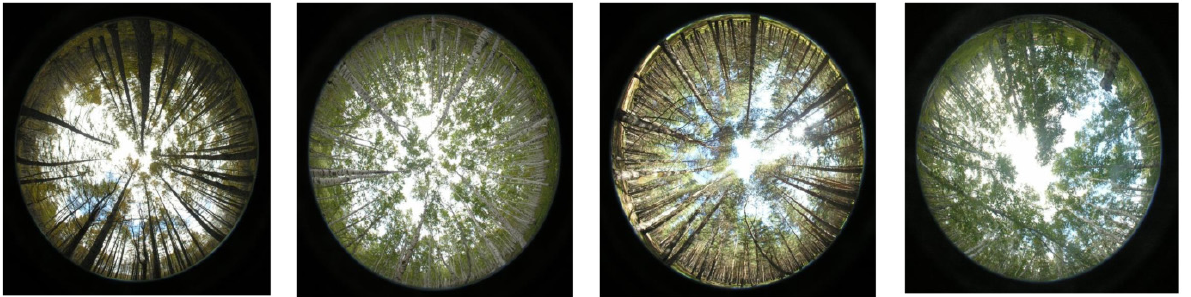
Figure 4. Partial display of fisheye photos in sample plots. The size of field plots was set 30 × 30 m, and three fisheye photos were acquired at each field plot randomly. FCC of each field plot was calculated as the mean FCC of three fisheye photos.